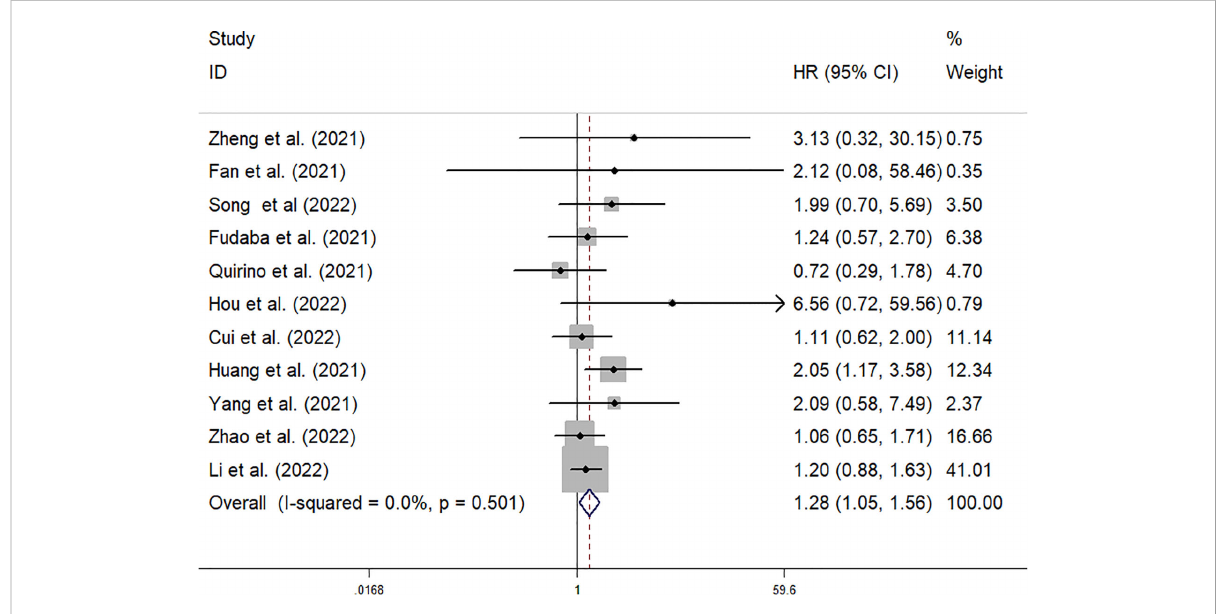
FIGURE 2 Forest plots of studies evaluating hazard ratios (HRs) of Siglec-15 for